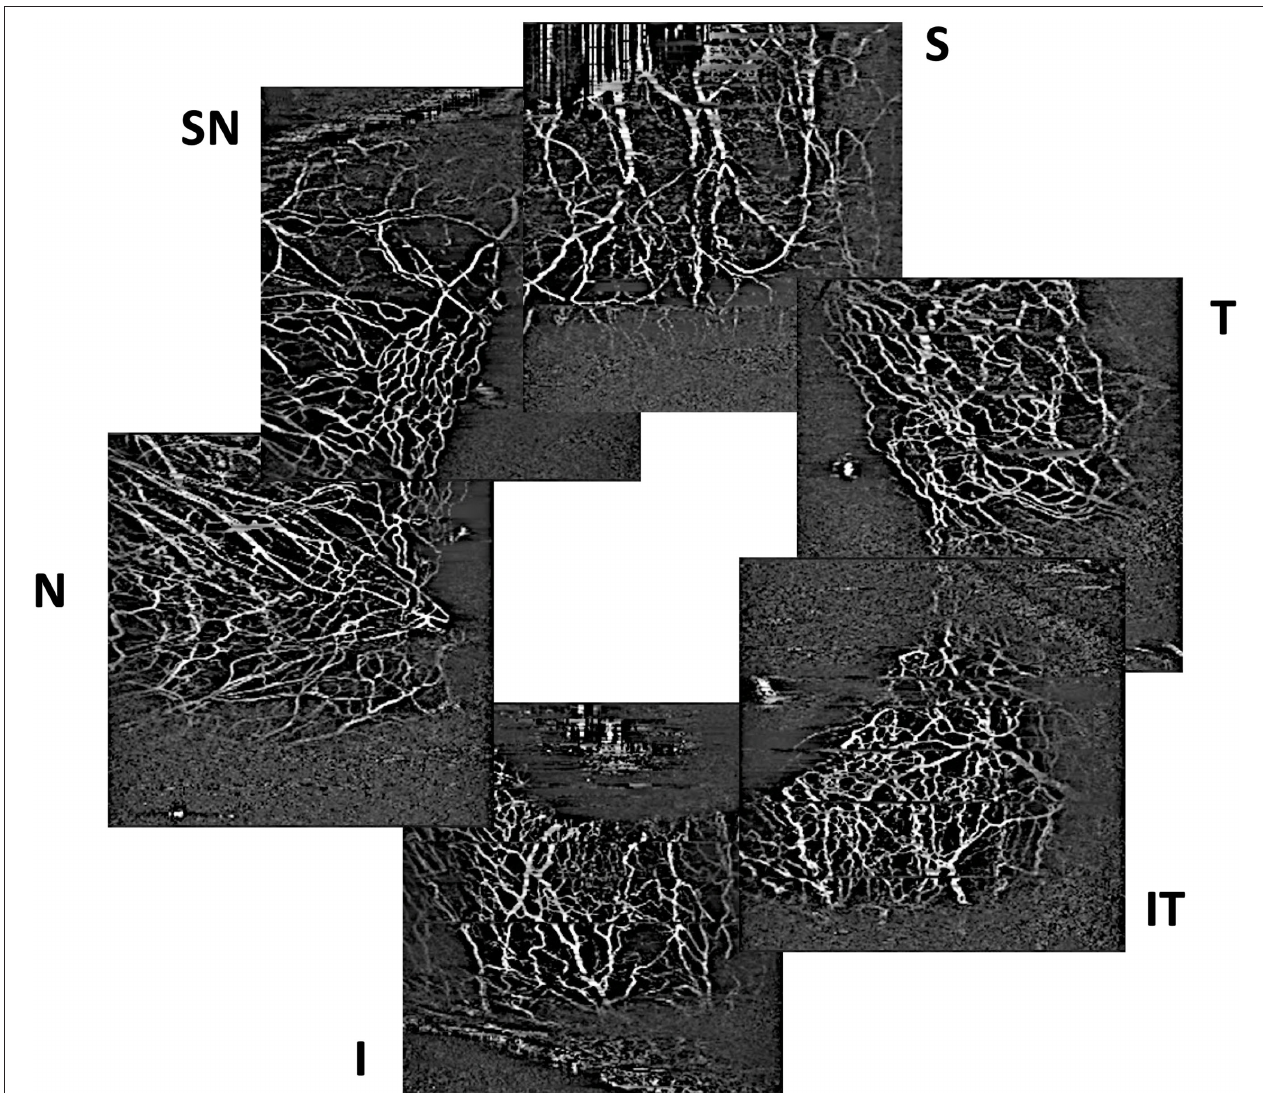
FIGURE 1 | Example of optical coherence tomography angiography scans of episcleral vessels acquired in sectors with the trabecular bypass minimally invasive glaucoma surgical device (S, superior; SN, superior nasal; N, nasal) and control sectors without the implant (I, inferior; IT, inferior temporal; T, temporal).